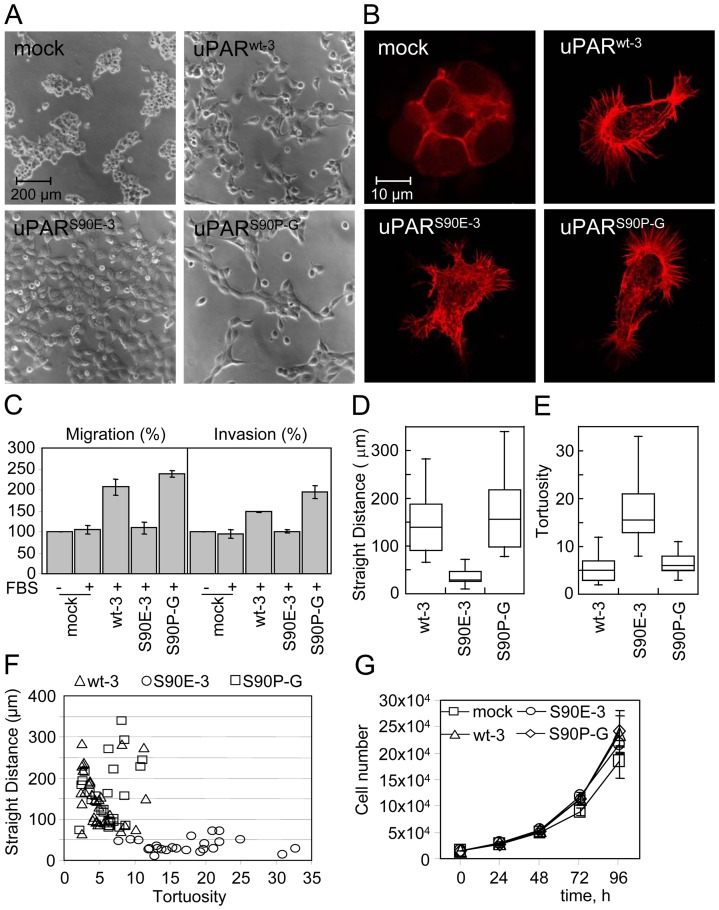
Expression of uPARS90E and uPARS90P induces changes in 293 cell morphology, cytoskeletal organization and migration without affecting cell proliferation. A–B. Representative images of the indicated transfected 293 clones analyzed by phase contrast microscopy (A) or stained with rhodamine-phalloidin (B). C. Cell migration and invasion of stably transfected 293 cells toward 10%FBS. The extent of migration or invasion is expressed as percentage of migrating or invading 293/mock cells in the absence of chemoattractant, considered as 100% (none). Data represent the means ± SD of three experiments in duplicate. D–E. Cell tracking analysis of the steady-state transfected 293 cells. Cells were recorded for 70 minutes every 15 sec. while kept at 37°C, under a 5% CO2 atmosphere. Ten cells/field were followed in a total of 3 independent experiments. Straight distance (D) and tortuosity (E) were quantified using the Axiovision 4.8 software (Carl Zeiss). In F straight distance versus tortuosity is plotted for each cell analyzed. G. Time-dependent proliferation of transfected 293 cells in growth medium. Data represent the means ± SD of three experiments, performed in duplicate.